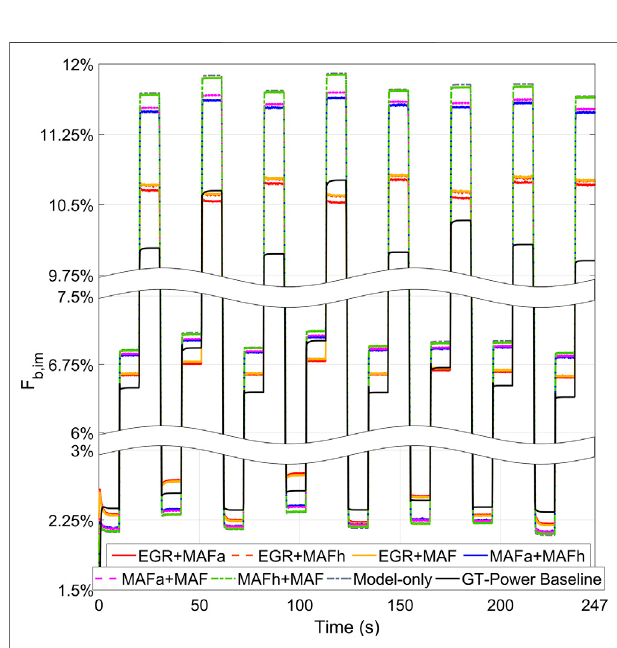
FIGURE 10 | Histograms of Intake manifold burnt gas mass fraction estimation error when only using one sensor.